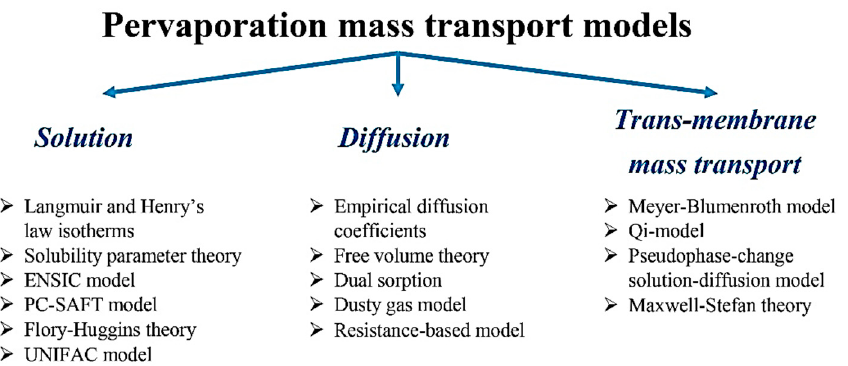
Figure 2. Models used for mass transfer in pervaporation.